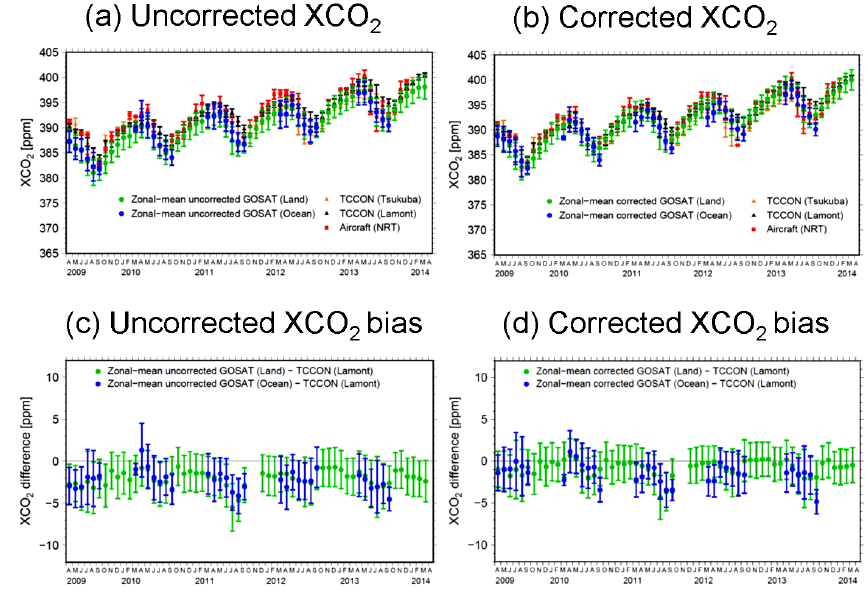
Figure 8. Temporal variations of (a) uncorrected and (b) corrected GOSAT XCO 2 , TCCON XCO 2 , and aircraft-based XCO 2 . Green and blue circles in (a) and (b) indicate the monthly zonal-mean GOSAT data retrieved over land and ocean regions, respectively, within a 30 ◦ –45 ◦ N latitudinal band. The orange triangles, black triangles, and red squares in (a) and (b) denote the TCCON XCO 2 at Tsukuba and Lamont, and aircraft-based XCO 2 at Narita, respectively. Temporal variations of the differences between (c) uncorrected and (d) corrected GOSAT XCO 2 and TCCON XCO 2 at Lamont (GOSAT XCO 2 minus TCCON XCO 2 ) over land (green circles) and ocean (blue circles). See text for